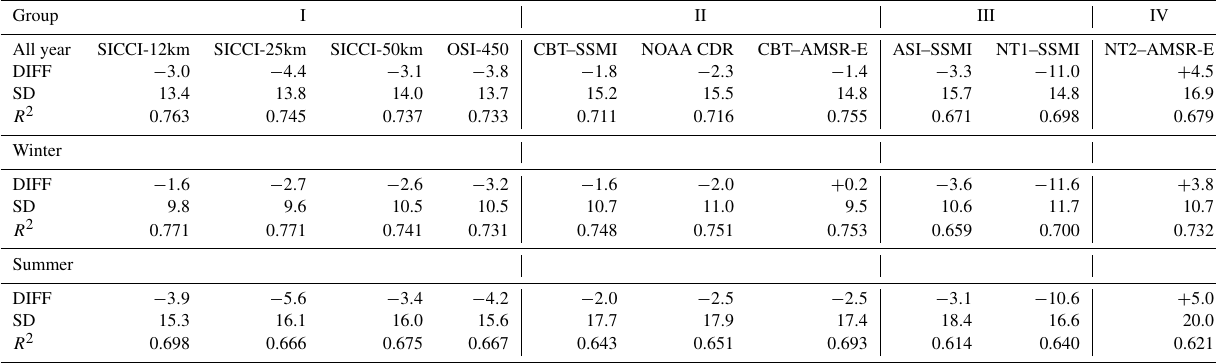
Table 6. As Table 5 but for the Antarctic (see Fig. 16, black symbols). Group